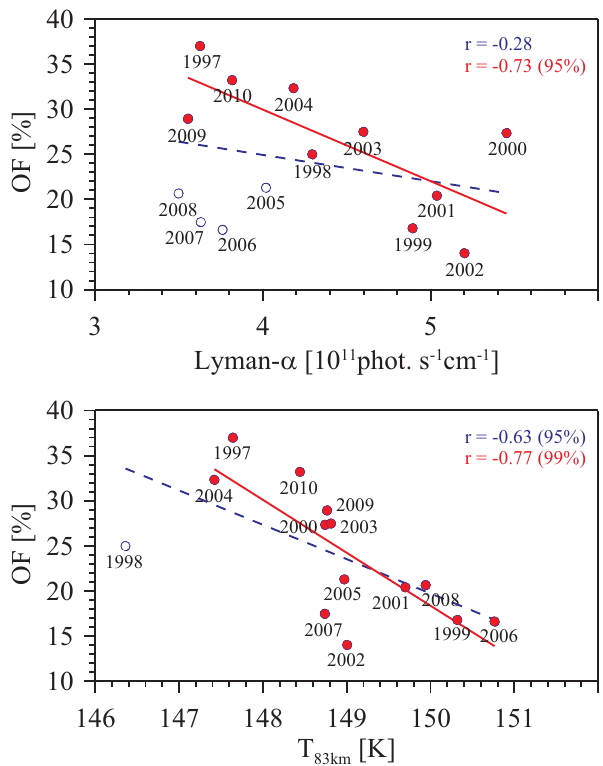
Fig. 13. Occurrence of NLC above the long-term limit ( β max > 4) at ALOMAR as function of solar activity (top) and temperature at 83km altitude (bottom). Lyman- α data are taken from http://lasp. colorado.edu/lisird/lya/ and averaged over the NLC season (1 June– 15 August). Temperatures are calculated by LIMA for times of lidar measurements. Blue colors/dashed lines represent the whole data set covering 14 years, whereas the outlier adjusted data subsets are indicated in red/solid lines. Significance levels of the correlation coefficients are given in